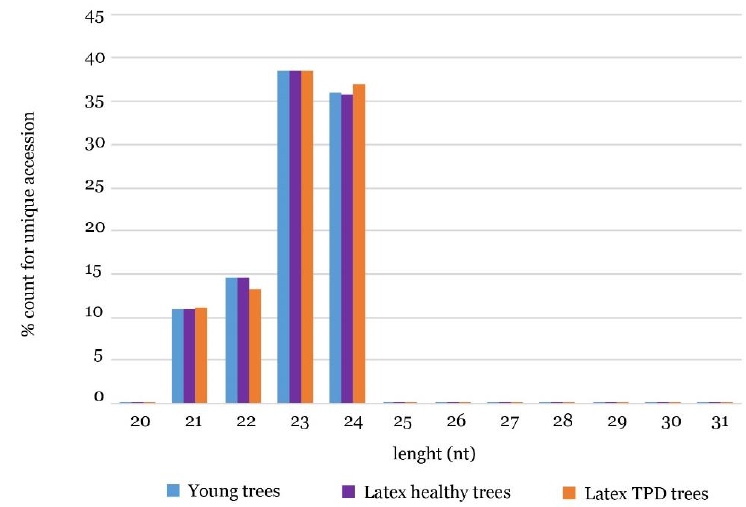
Figure 5. Length distribution of unique TE-derived small RNA accessions from Hevea tissues: (young trees ( • ), latex fromhealthy trees ( • ) and latex from TPD-a ff ected trees ( • )).